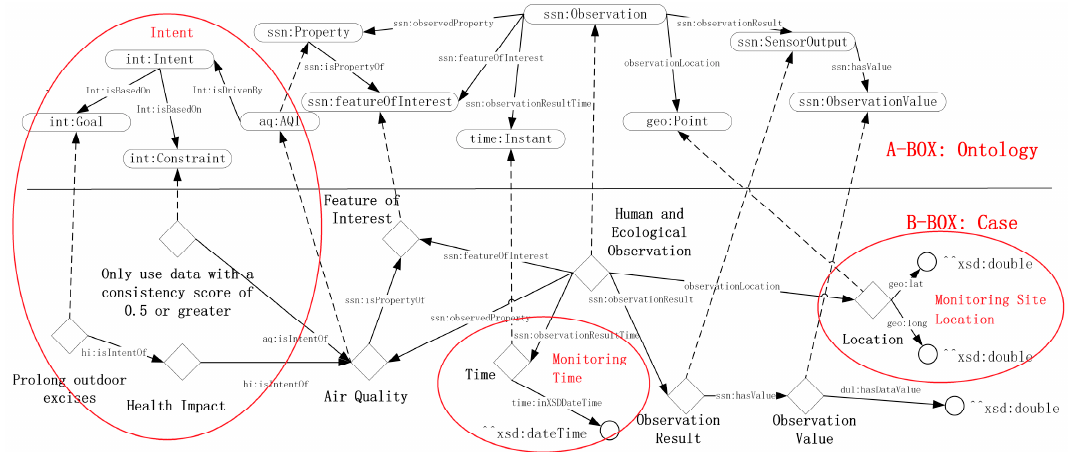
Figure 11. Ontology-case statements for querying air quality and health implications.